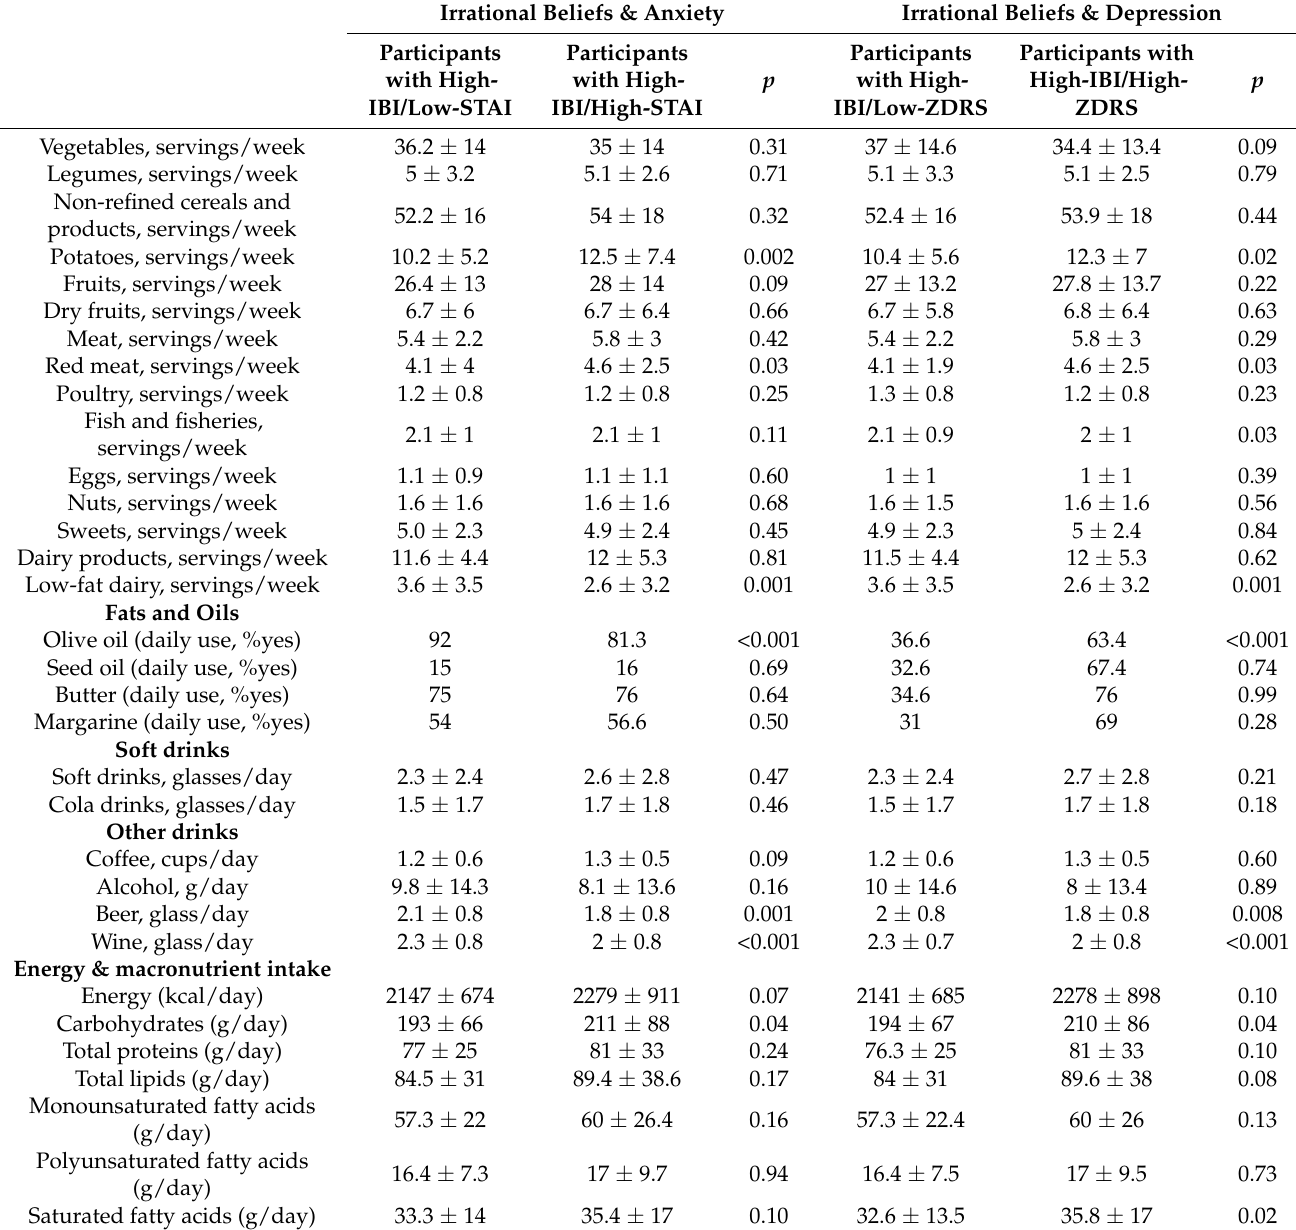
Table 2. Food groups and nutrient consumption according to participants with a high IBI score ( ≥ 52), who also had